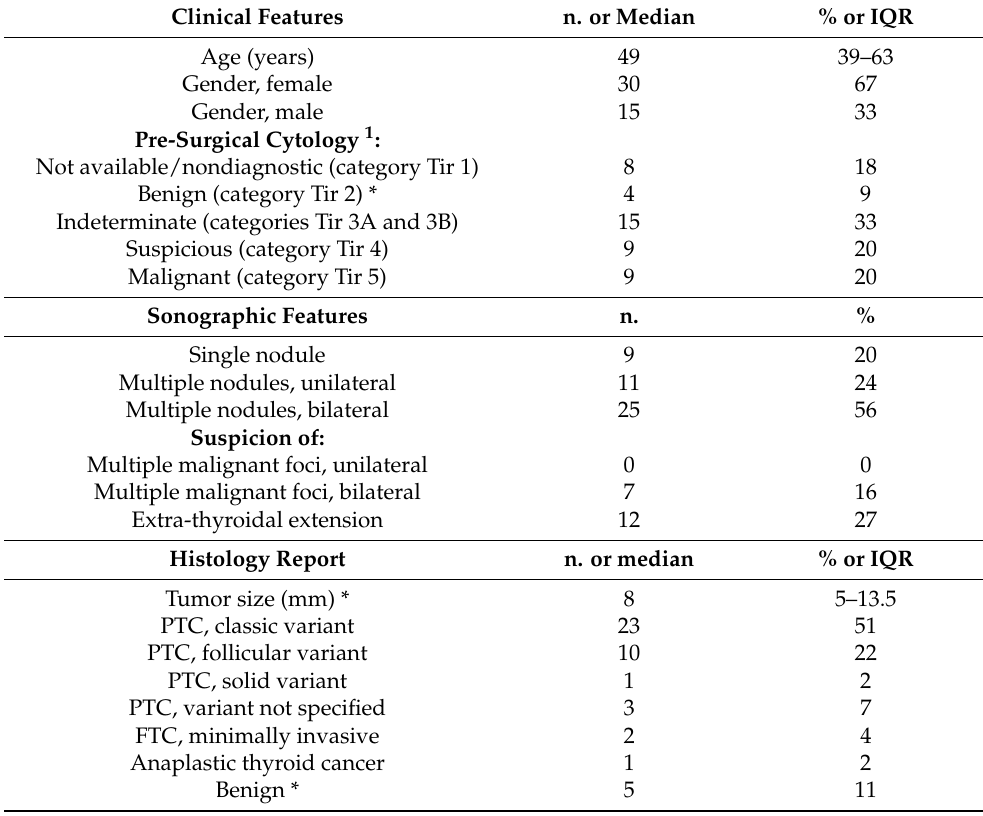
Table 1. Clinical, sonographic, and pathological features of the study